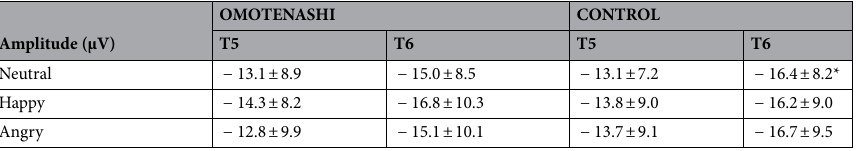
Table 5. Maximum amplitude of N170 at T5 (left) and T6 (right) for Neutral, Happy, and Angry stimulus conditions in OMOTENASHI and CONTROL. Data are presented as the mean and standard deviation for each group. *p < 0.05: comparison with